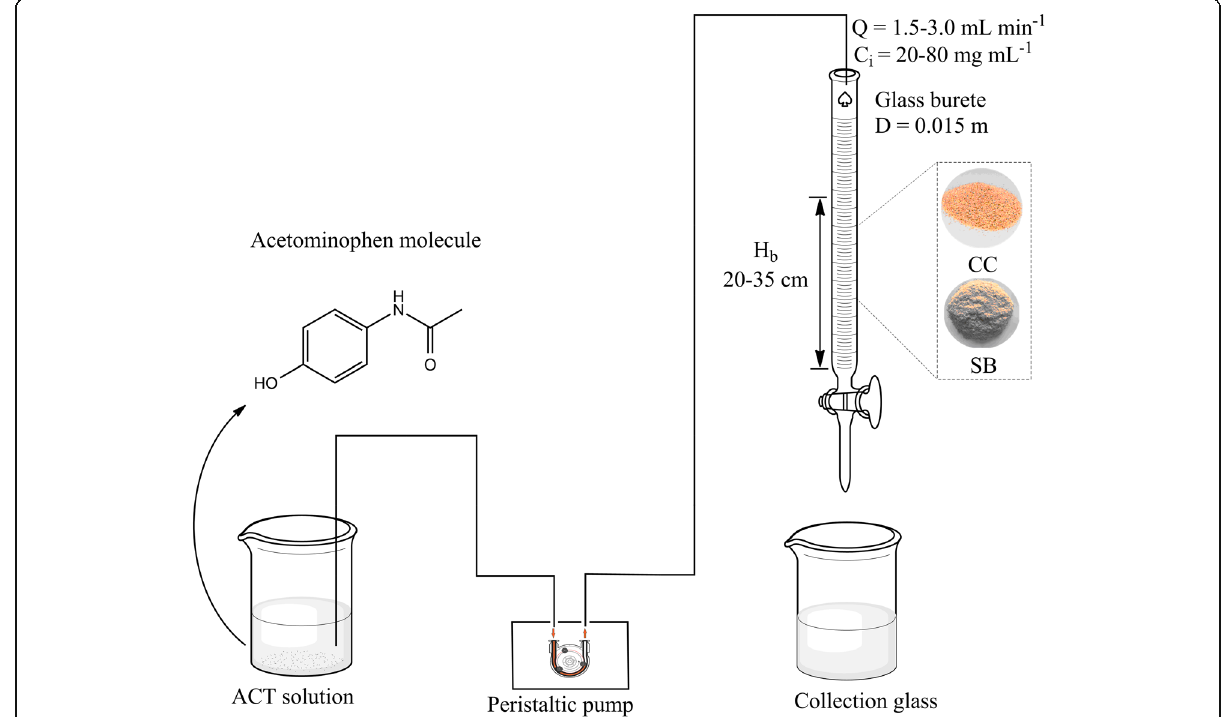
Fig. 2 Diagram of the experimental adsorption